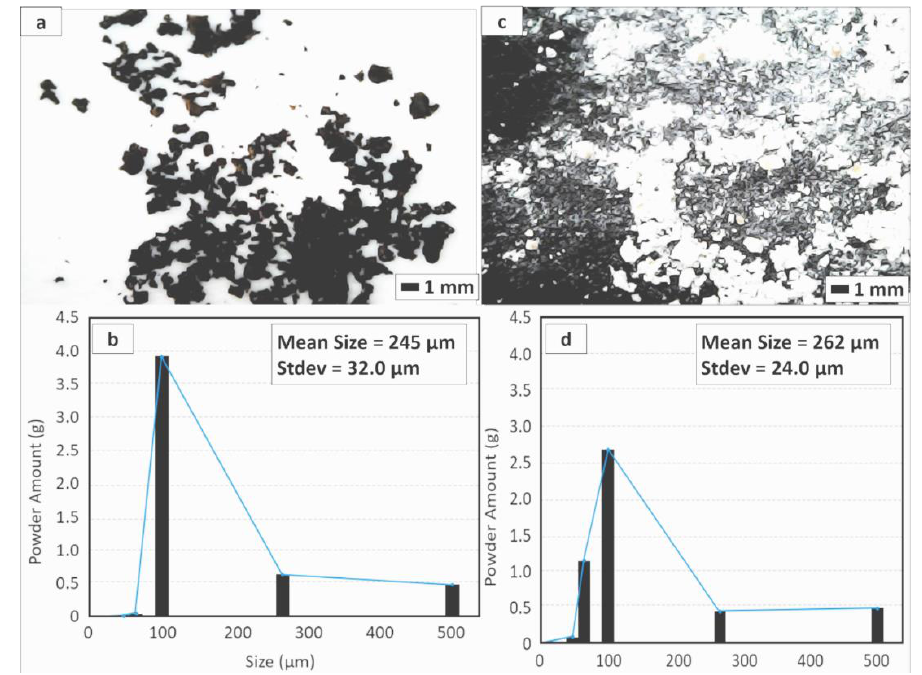
Fig. 3. Photograph images of the particles: (a) BP particles and (b) E particles. Particle size distribution: (c) BP particles and (d) E particles